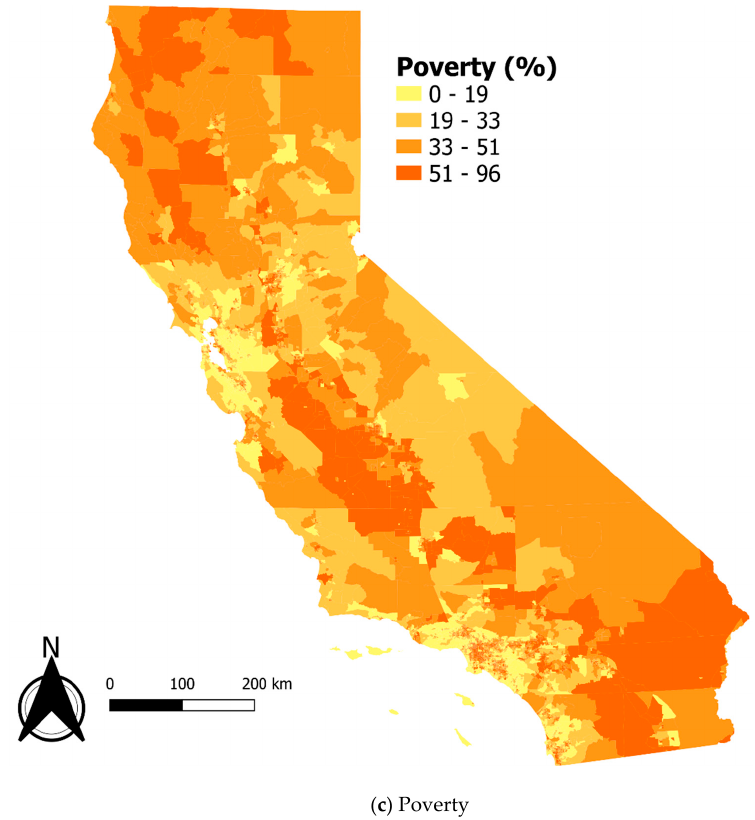
Figure 2. Choropleth maps of California using data from CalEnviroScreen: ( a ) PM 2.5 . ( b ) Percentage of low birth weight infants. ( c ) Percentage of households in poverty. PM 2.5 was positively associated with low birth weight (LBW) in both adjusted and unadjusted models. After adjusting for percentage of the population living in poverty, percentage race/ethnicity, and toxic releases from facilities, the association between PM 2.5 and LBW remained significantly positive. There was a 0.03% (95% CI: 0.01, 0.04) increase in the percentage of LBW infants for every 1 µg m -3 increase in average annual mean con- centration of PM 2.5 in a census tract after adjustment (Table 2). Table 2. Percent change in low birth weight per 1 µg m -3 change in PM 2.5 stratified by percent pov- erty in California census tracts.